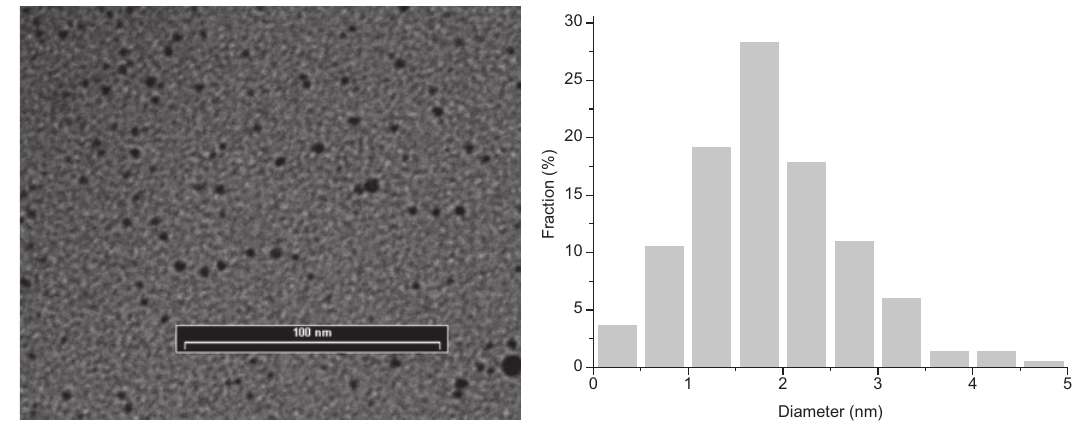
Figure 3 TEM micrograph and particle-size distribution of a nanocomposite sample (1 % by weight of [Ag(hfac)(COD)]). As visible, quite pseudo-spherical silver particles of ca. 1.8 nm are present.